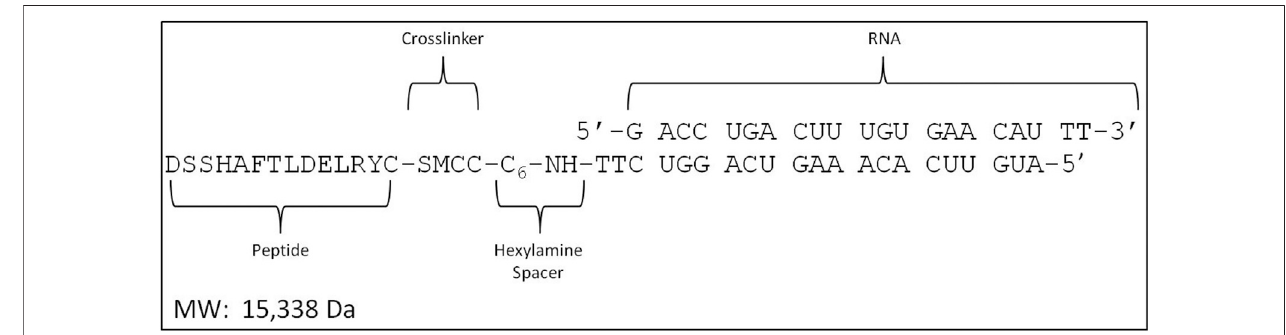
FIGURE 1 | Design of the MTfp-RNA conjugates. SMCC, succinimidyl 4-(N- maleimidomethyl)